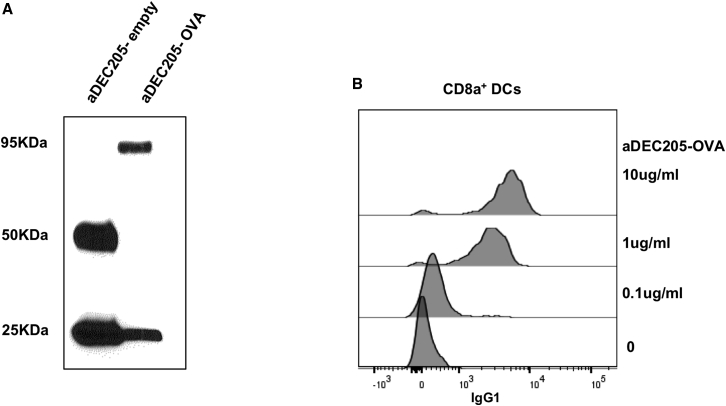
Production and Characterization of aDEC205-OVA(A) aDEC205-OVA and aDEC205-empty were generated by transfection of 293T cells in vitro and subsequent purification of the antibody. (A) Final antibody product was reduced by β-mercaptoethanol and verified by immunoblotting for the heavy and light chains. aDEC205-empty shows a heavy chain at 50 kDa and light chain at 25 kDa. aDEC205-OVA shows the heavy chain linked with OVA at 95 kDa, indicating the presence of OVA antigen and a light chain at 25 kDa. (B) A binding assay was performed to verify effective binding of aDEC205-OVA to the DEC205 receptor on CD11c+CD8+ dendritic cells (DCs) isolated from murine splenocytes. aDEC205-OVA is probed with an anti-IgG1-APC antibody and detected by flow cytometry. The histogram overlay depicts high binding of aDEC205-OVA to CD11c+CD8+ DCs at concentrations of 10 μg/mL and 1 μg/mL and low binding at 0.1 μg/mL.